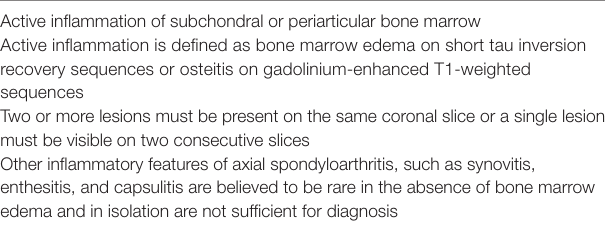
TAble 4 | Features of an Assessment of SpondyloArthritis Society definition of positive magnetic resonance imaging for sacroiliitis (37). Active inflammation of subchondral or periarticular bone marrow Active inflammation is defined as bone marrow edema on short tau inversion recovery sequences or osteitis on gadolinium-enhanced T1-weighted sequences Two or more lesions must be present on the same coronal slice or a single lesion must be visible on two consecutive slices Other inflammatory features of axial spondyloarthritis, such as synovitis, enthesitis, and capsulitis are believed to be rare in the absence of bone marrow edema and in isolation are not sufficient for diagnosis